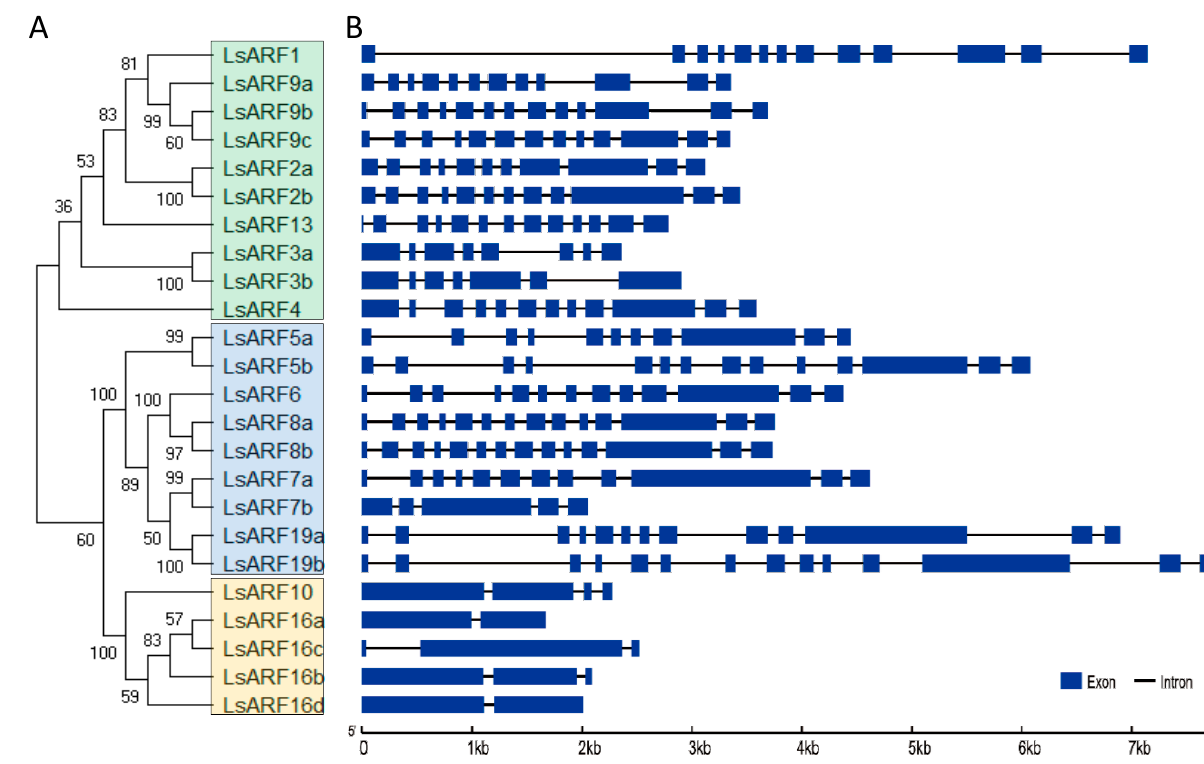
Figure 2. Classification of L. sativa ARF proteins. ( A ). Neighbor-joining tree were generated using MEGA to determine the phylogenetic relationship between L. sativa ARF proteins (left). According to classification proposed by Finet et al. (2013), LsARFs were divided into three subgroups: A (top), B (middle) and C (bottom), and shadow colors were used to distinguish different LsARF subgroups. ( B ). The intron–exon organization of LsARF genes was plotted using Gene Structure Display Server (Version 2.0). Blue boxes represent exons, and grey lines represent introns.